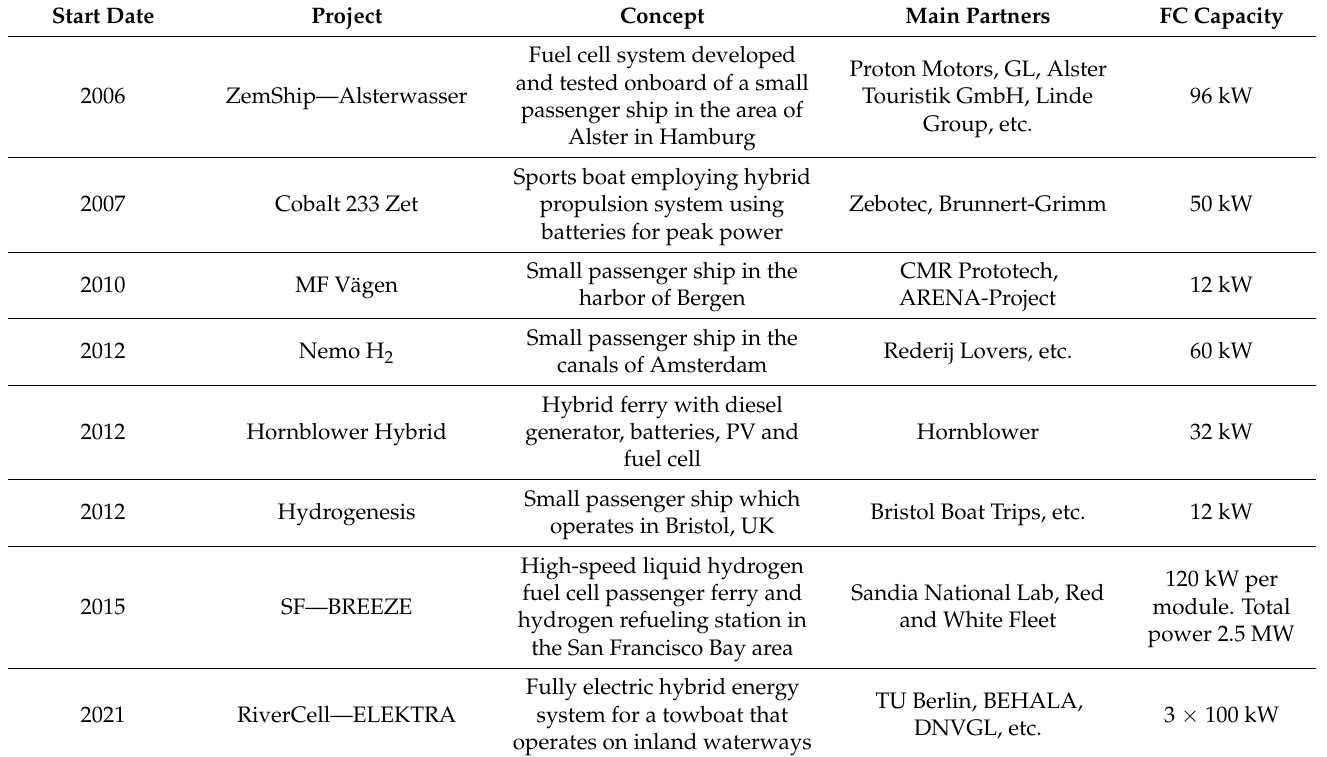
Table 3. Noticeable demonstration ship projects of marine fuel cell systems using H 2 as fuel since 2000 (adapted from